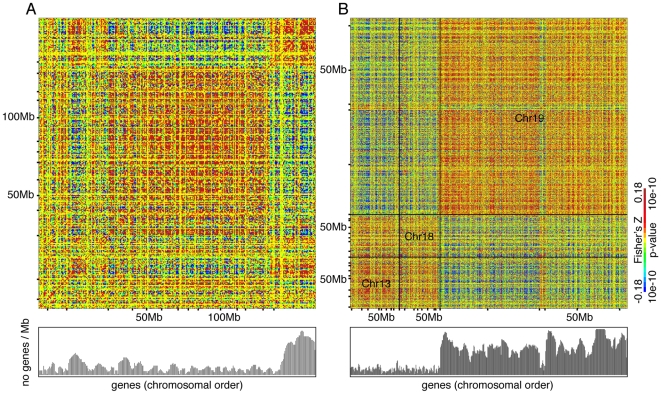
Evidence for coexpression domains.Z-transformed Pearson's correlation coefficients are displayed as a heat-map. The magnitude of the correlation coefficients is displayed using a color scale, truncated at the range displayed in the legend. Gene density, defined as the number of protein-coding genes in a 1 Mb window centered on each gene, in the lower panel; they were truncated at 50 genes/Mb. (A) Human chromosome 8 (B) Human chromosomes 13, 18, and 19. Chromosomes are demarcated by dotted lines.